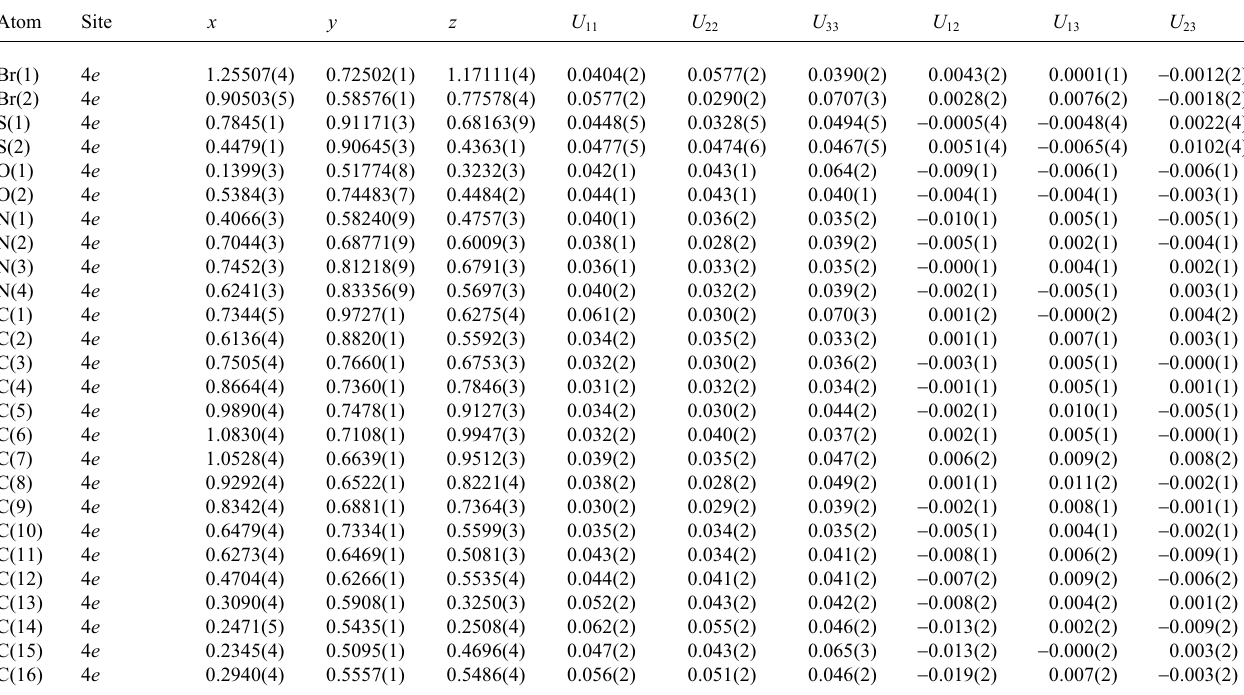
Table 3. Atomic coordinates and displacement parameters (in Å 2 )